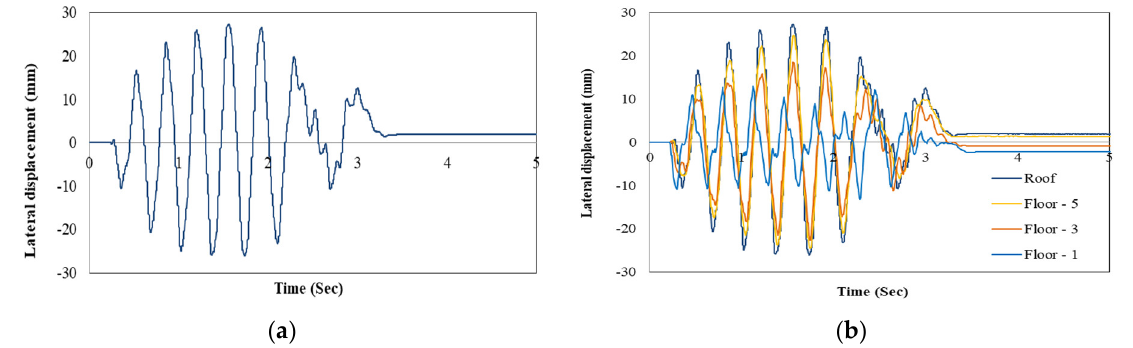
Figure 13. Typical experimental time-history displacement results of the fixed-base structure: ( a ) only at roof level, and ( b ) comparison of the displacements with other floors.